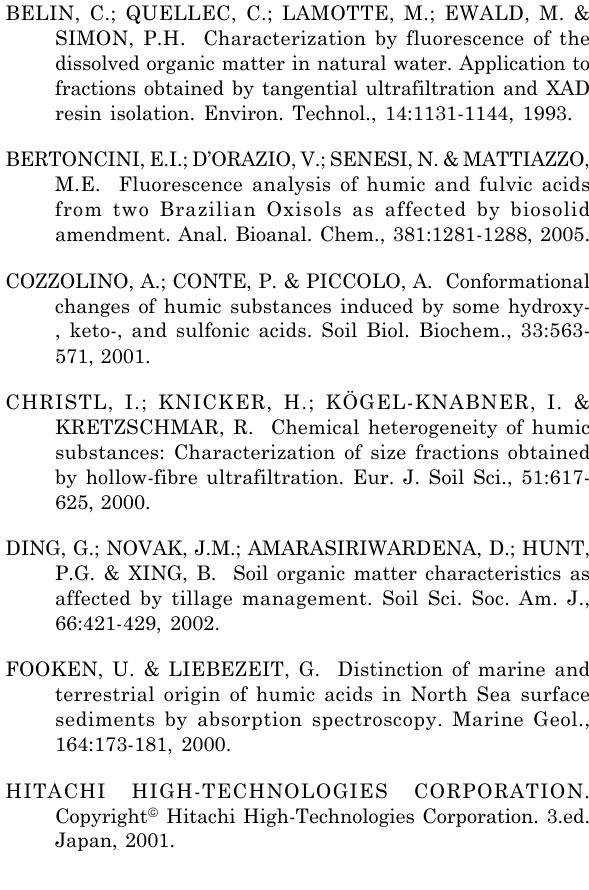
Table 1. Excitation/emission wavelength pairs (EEWP, nm/nm) of the main peak maxima in total luminescence spectra and the corresponding humic and fulvic acid fluorescence intensities (FI